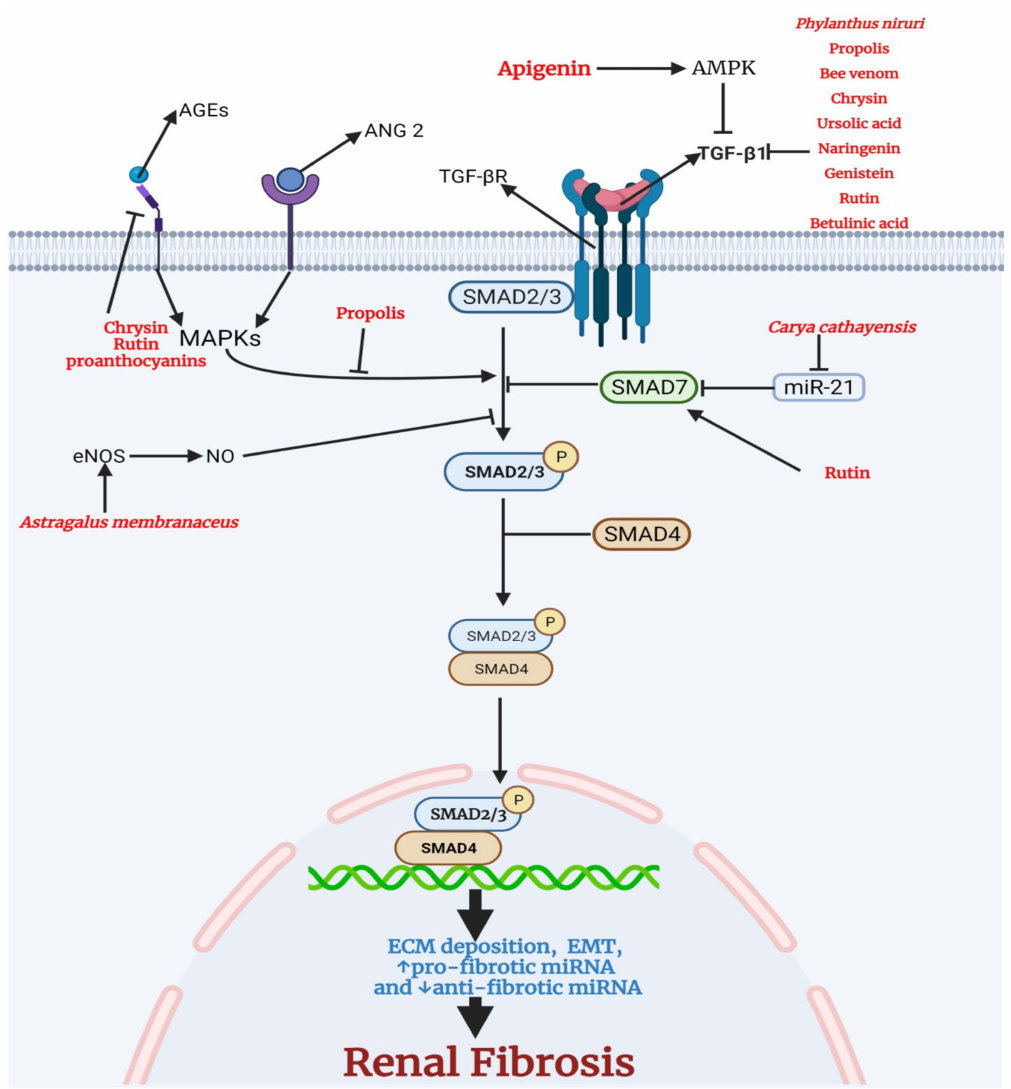
Figure 5. Medicinal plants and bioactive compounds with anti-fibrotic activity. The canonical transforming growth factor-beta1 (TGF β 1) pathway involves the binding of TGF β 1 to transforming growth factor-beta receptor (TGFBR). This leads to the phosphorylation and activation of small mothers against decapentaplegic 2/3 (SMAD 2/3). SMAD7, the inhibitory SMAD, inhibits the activation of SMAD 2/3 by the TGFBR. SMAD 7 is negatively regulated by microRNA-21 (miR- 21). Active SMAD 2/3 binds the common SMAD (SMAD 4) and translocates to the nucleus to drive the transcription of genes encoding proteins that make up the extracellular matrix, proteins that are involved in epithelial to mesenchymal transition, and pro-fibrotic miRNA. The advanced glycation end products (AGEs) and angiotensin II (ANG 2) drive the activation of MAPKs that activate SMAD 2/3. Nitric oxide (NO) is involved in the inhibition of SMAD 2/3. Chrysin, rutin, and proanthocyanins inhibit the receptor for advanced glycation end products (RAGE), thus reducing the activation of MAPKs. In addition, propolis inhibits the activation of SMAD 2/3 by MAPKs. Astragalus membranaceus increases endothelial nitric oxide synthase (eNOS) and the level NO. A high level of NO inhibits the activation of SMAD 2/3. Rutin directly activates SMAD 7, leading to a reduction in activation of SMAD 2/3. Carya cathayensis inhibits miR-21, the negative modulator of SMAD7. Phylanthus niruri , propolis, bee venom, chrysin, ursolic acid, naringenin, genistein, rutin, betulinic acid reduce the level of TGF β 1, thus inhibiting the activation of TGFBR. Apigenin activates AMPK leading to a decrease in the level of TGF β